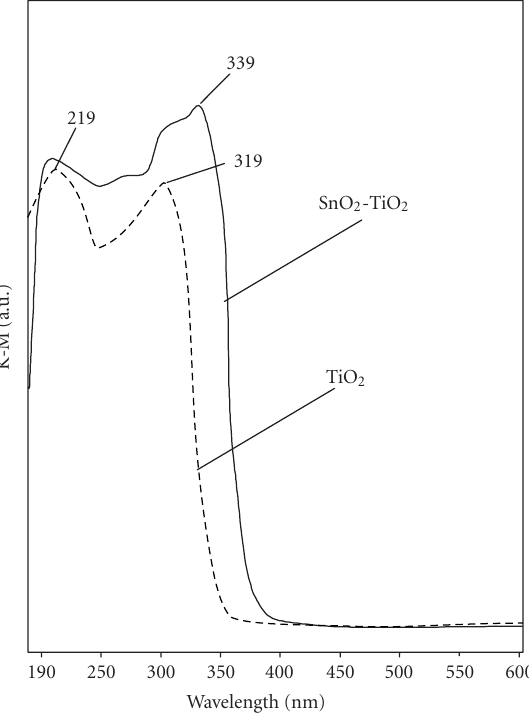
Figure 2: UV-Vis DR spectra of photocatalysts in the range of wave- length from 190 to 600 nm.